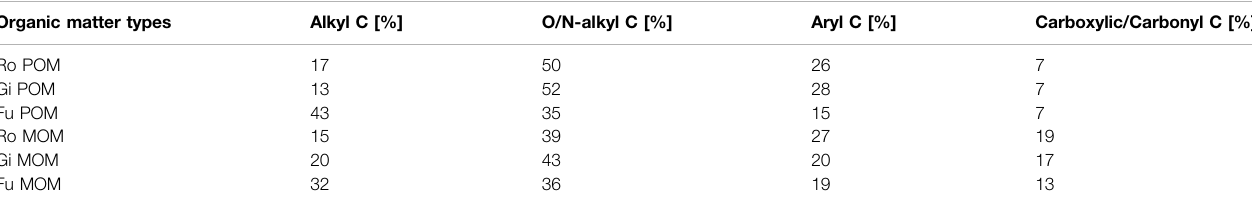
For the three POM fractions, a mixture of free and occluded POM (according to mass contributions in bulk soils) was used. Values represent the percentage contribution of the different integrated chemical shift regions determined by 13 C-CPMAS NMR